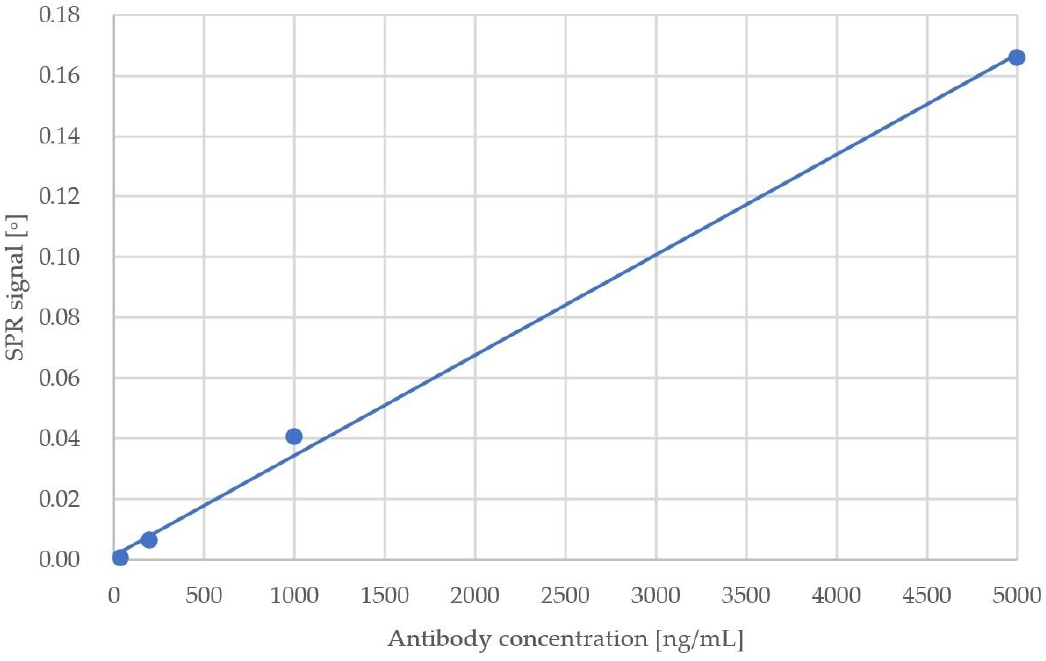
Figure 2. SPR signal against antibody concentration in the buffer.